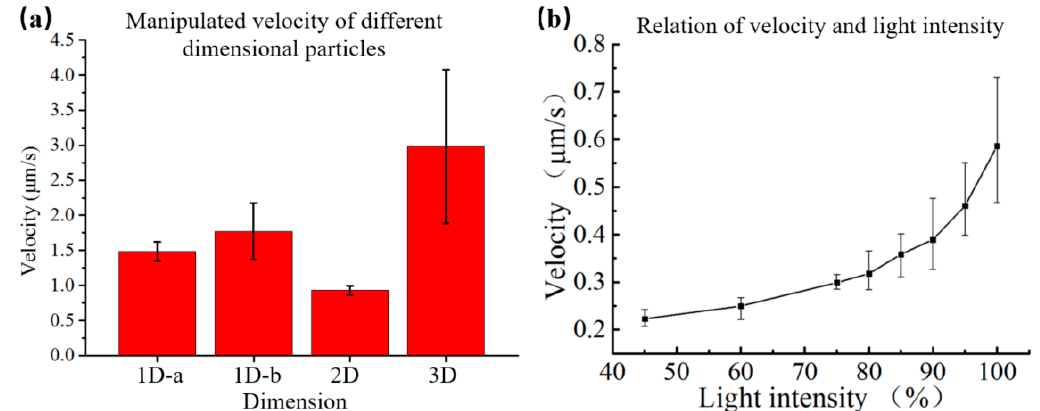
Figure 9. Manipulation velocity of particles with different shapes via OET. ( a ) Manipulation velocity of particles with different dimensions; ( b ) Relation of the velocity and input light intensity.